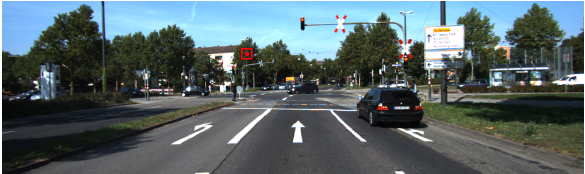
Figure 2: The projection transformation of the traffic light is approximated using the position of the traffic light in Open- StreetMap. The projected traffic light lens into the image space is shown with a circle and a rectangle is drawn around it for better